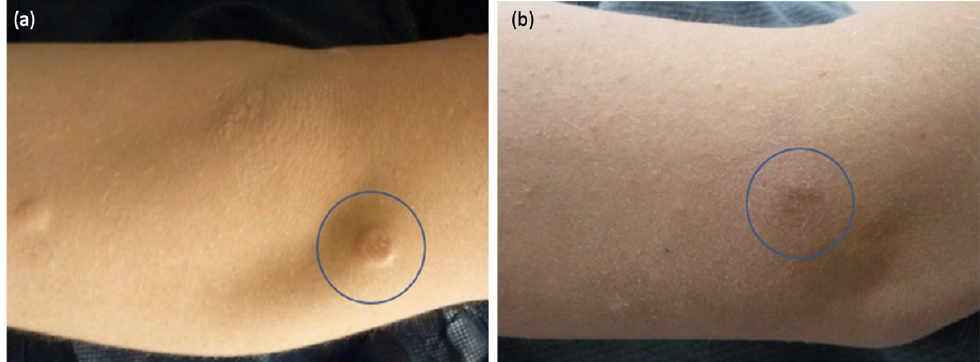
Figure 2. Right arm pink-yellow papule, before ( a ) and after ( b ) intralesional